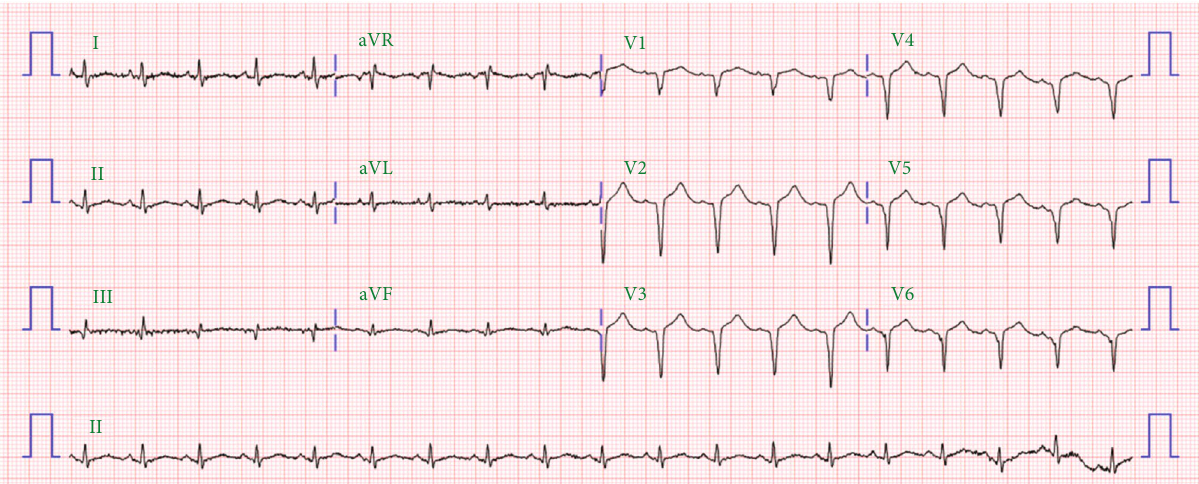
Figure 3: A second ECG taken after ROSC following cardiopulmonary arrest. ECG shows QT prolongation. ECG: electrocardiogram; ROSC: return of spontaneous circulation.